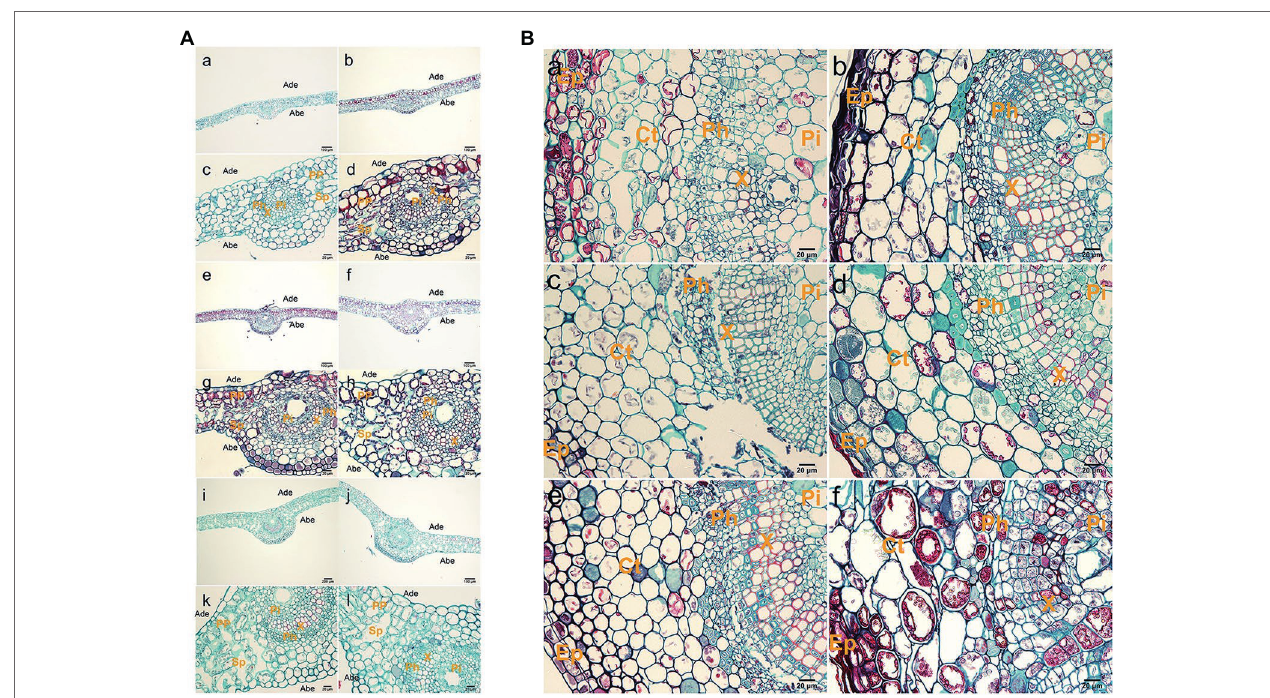
FIGURE 2 | Histological observations of leaves and stems. (A) Anatomy of a leaf cross section from hybrid sweetgum. a , c , e , g , i , k Cross-section of a diploid leaf; b , d , f , h , g , l cross section of a tetraploid leaf. a–d 25 d; e–h 50 d; i–l : 70 d. Ade: adaxial epidermis; Abe: abaxial epidermis; PP: palisade parenchyma; Sp: spongy parenchyma; Pi: pith; Ph: phloem; X: xylem. Bars are 200 μ m in a,b,e,f,i,j ; they are 20 μ m in c,d,g,h,k,l . (B) Anatomy of a stem cross section from hybrid sweetgum. a , c , e Cross section of a diploid shoot; b , d , f cross-section of a tetraploid shoot. a , b 25 d; c , d 50 d; e,f 70 d. Ct: cortex; Ep: epidermis; Pi: pith; Ph: phloem; X: xylem. Bars are 200 μ m in a,b,e,f ; they are 20 μ m in c , d .